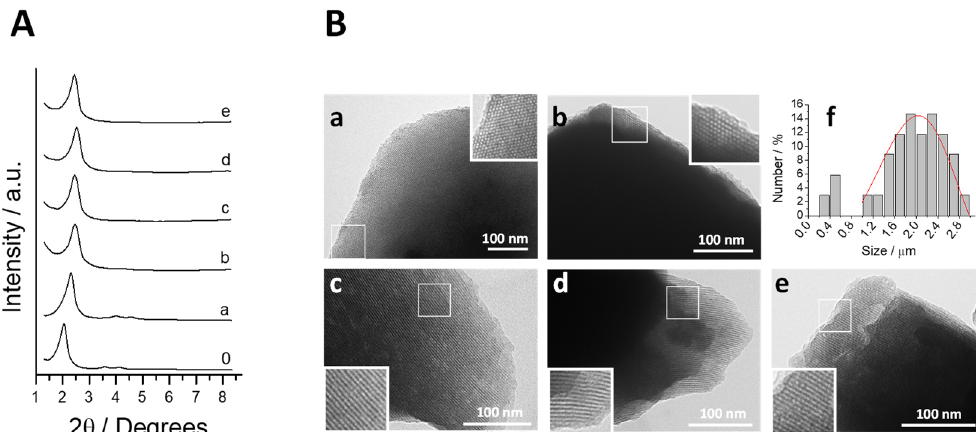
Figure 1. ( A ) Normalized powder X-ray patterns of all the synthesized solids. From bottom to top, the reported solids are the as made material (0), the calcined support M41 ( a ) and the loaded and functionalized final materials: M41-RhB-L ( b ), M41-Thy-L ( c ), M41-Eug-L ( d ) and M41-Cin-L ( e ). ( B ) TEM micrographs of starting bare material M41 ( a ), and loaded and functionalized solids M41-RhB-L ( b ), M41-Thy-L ( c ), M41-Eug-L ( d ) and M41-Cin-L ( e ), and particle size estimation ( f ). Insets correspond to a 2x magnification of the selected areas.